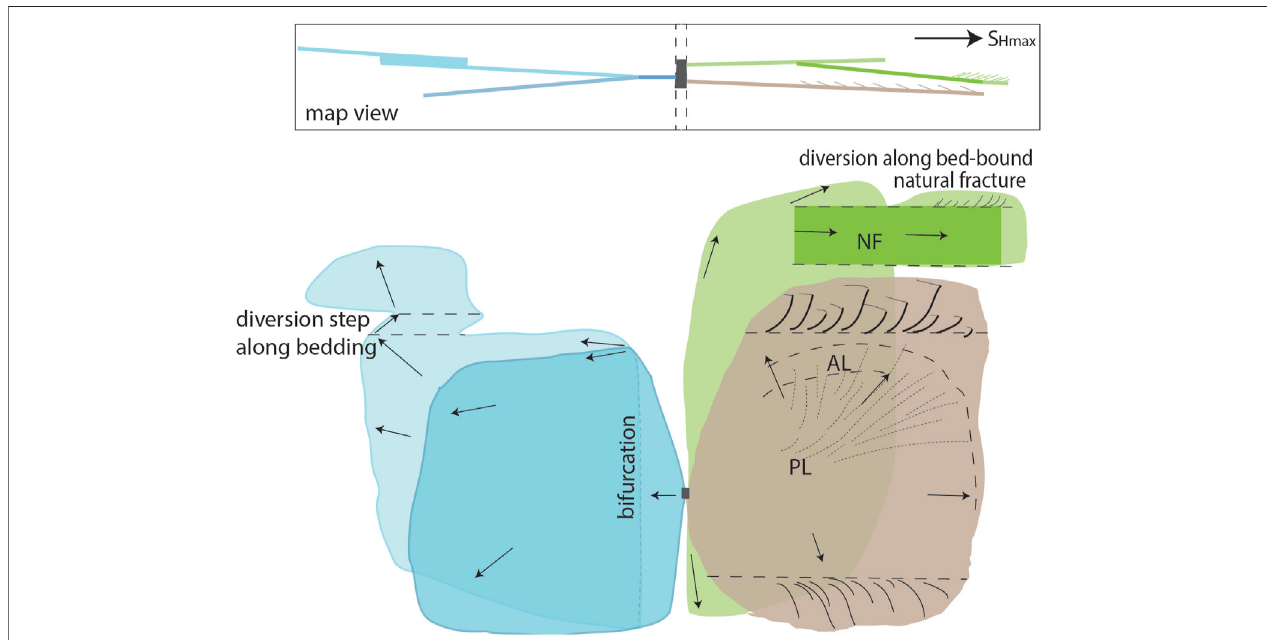
FIGURE13| Schematicdiagram showingmap view (inset) ofpro fi le view of interpreted hydraulicfracturemorphologies. Pointsource(grey rectangle) gives rise to three fractures (blue, buff, and green planes). Buff and green fractures propagate to the right and are slightly divergent. Morphological features: plumose markings, PL; arrest lines, AL; twist hackles, TH. Bedding: horizontal dashed lines. Propagation directions: arrows. The green fracture is featureless, until it partially diverts along a bed-bound natural fracture, and then continues upwards, but segments into small twist hackles. The blue fracture propagates in the opposite direction; the parent fracture is subparallel to the other fractures and S Hmax until it bifurcates. The dark blue segment is in the foreground and is featureless. The light blue fracture diverts along bedding. Scale: a few cm to many tens of meters.